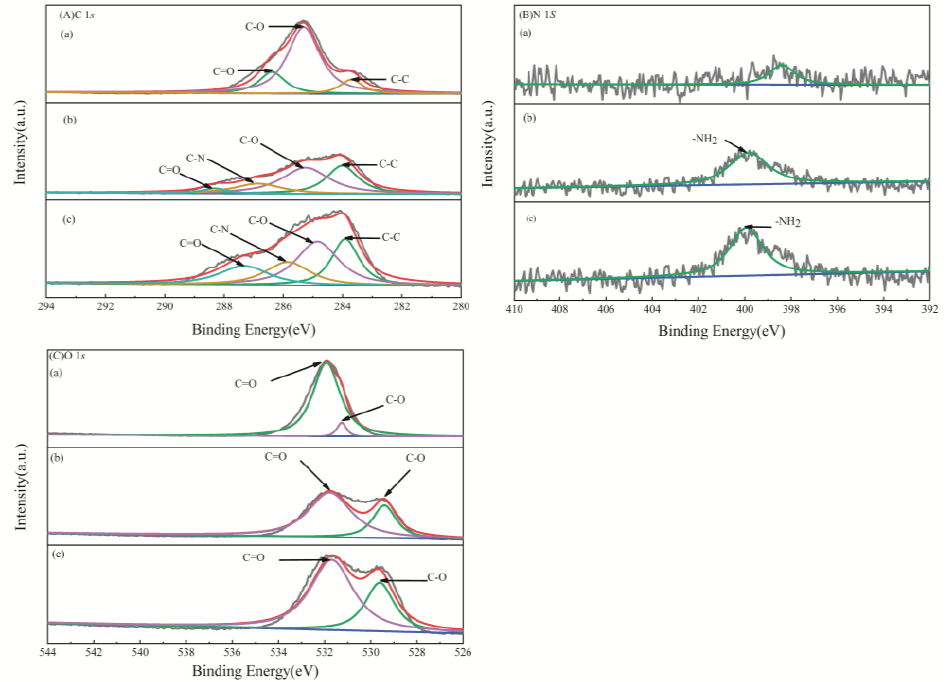
Figure 3. XPS profiles of C 1 s ( A ), O 1 s ( B ), and N 1 s ( C ) in the MS ( a ), AAM-MSMPM ( b ), and Cd(II)/AAM-MSMPM ( c ). Table 1. Binding energies of the core electrons of the MS, AAM-MSMPM, and Cd(II)/AAM- MSMPM.